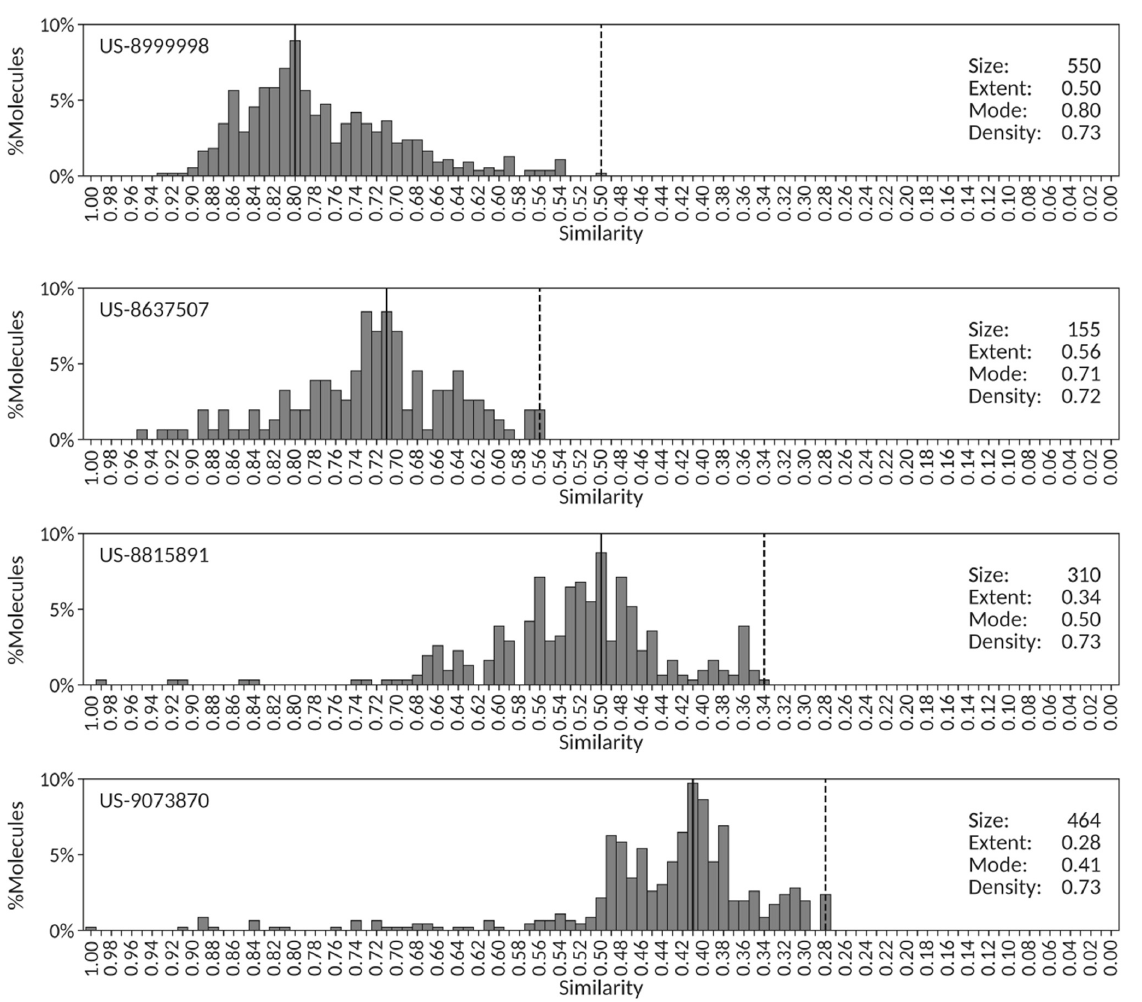
Figure 5. Centroid similarity distributions for four patents with almost identical density values. The mode and the extent are indicated, respectively, by vertically solid and dashed lines.